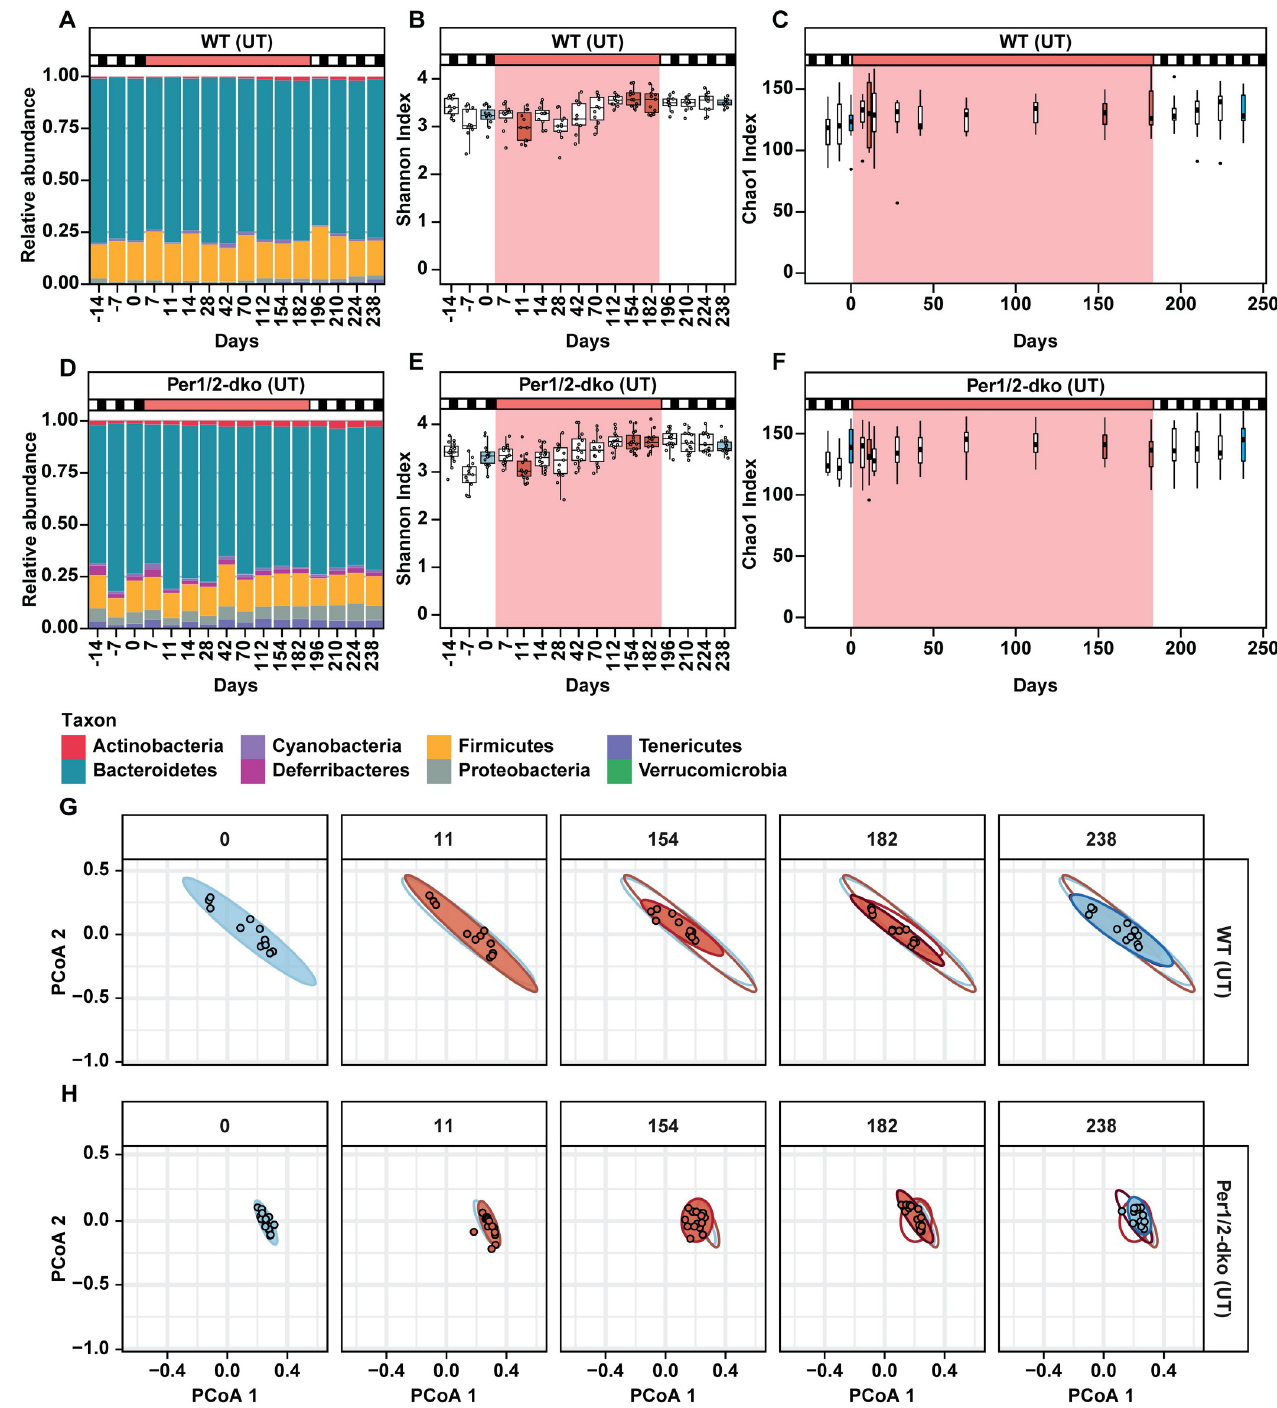
Fig 2. Alpha- and beta-diversity characterizations of the responses of gut microbiome to rhythmic vs. non-rhythmic host behaviors. Sample groups are labeled as in Fig 1A: WT(UT) and Per(UT) for the untreated WT and Per1/2-dko groups that were transferred from LD to RR on Day 0 and back to LD on Day 182. The data used to compile this figure are included in S1 Data File. (A and D) Quantification of the average relative abundances of the microbiota at the phylum level based on 16S sequences at various time points during the regimen in the 4 groups. The upper abscissae for panels A–F indicate LD conditions (black/white boxes) and RR (red). (B and E) Shannon index analyses of alpha-diversity of the microbiota at various time points during the regimen in the 4 groups. The Shannon diversity index is a measure of biodiversity that deals with richness and evenness of species [28]. The data of this diversity index are plotted with the time points equally spaced along the abscissae to mostly emphasize the significance level of each data point. Colored boxes refer to the time